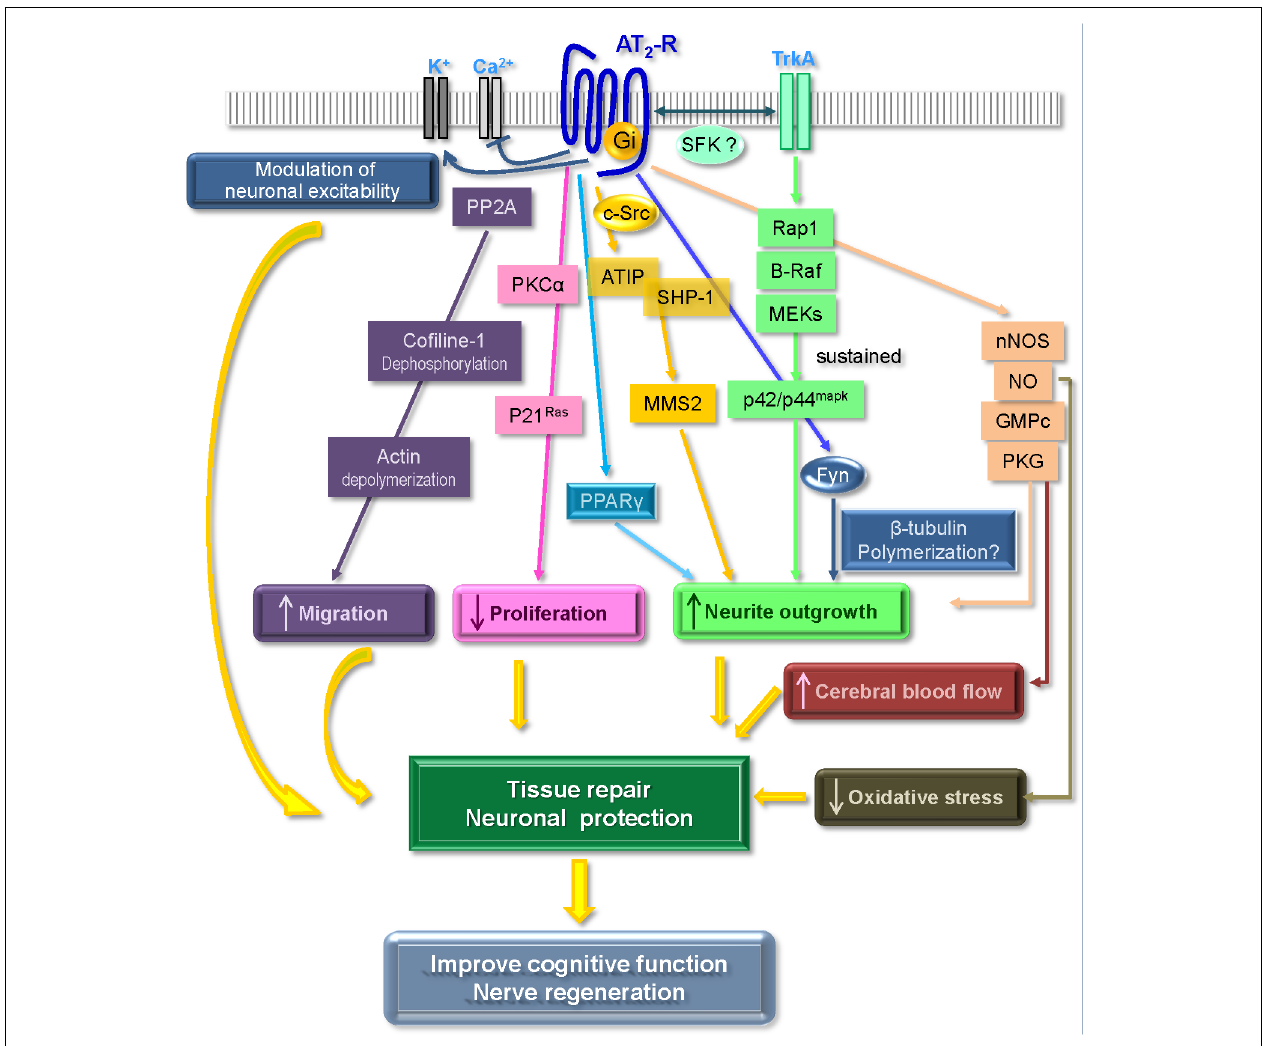
FIGURE 1 | Main signaling pathways associated withAT 2 receptor activation leading to neuroprotective effects (see text for details). Adapted from Gallo-Payet etal.